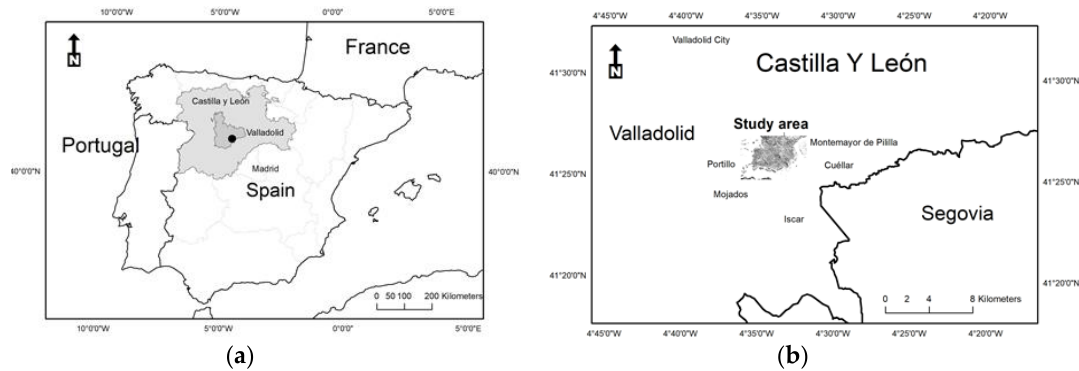
Figure 1. ( a ) Location of the study area in Spain, and specifically in the province of Valladolid (region of Castilla y León); ( b ) the study area is located in the south-east limit, close to the limit with Segovia.